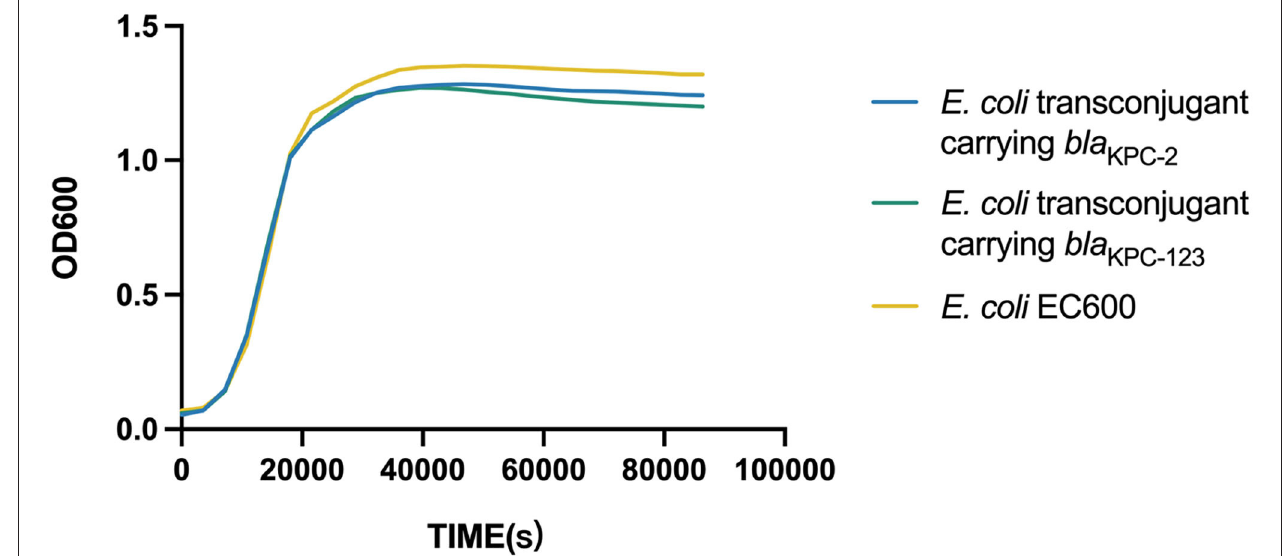
FIGURE 2 | Growth curve of E. coli and the transconjugants carrying the bla KPC -bearing plasmid.